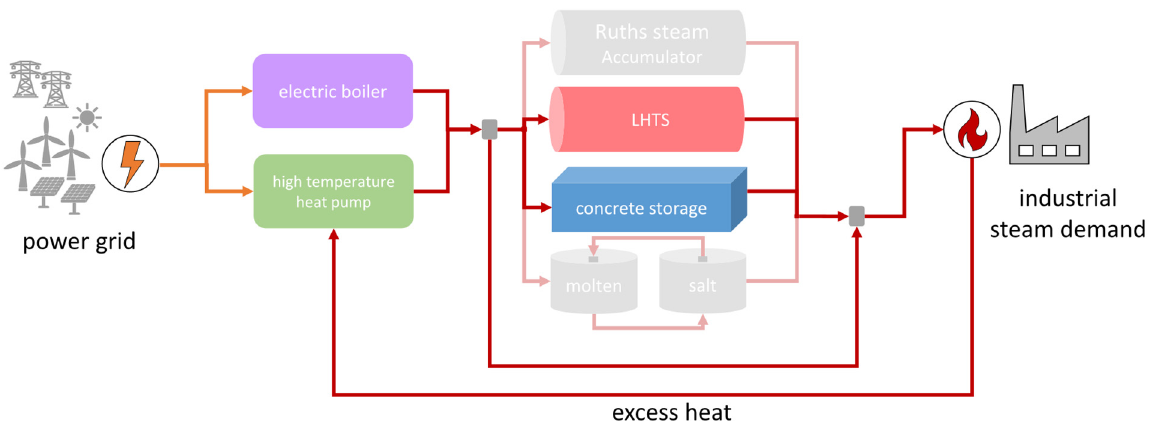
Figure 15. Optimal P2H system for Case 2 including electric boilers, high-temperature heat pumps, LHTS and concrete storage. Table 5. Optimal system configuration and resulting costs for Case 2.